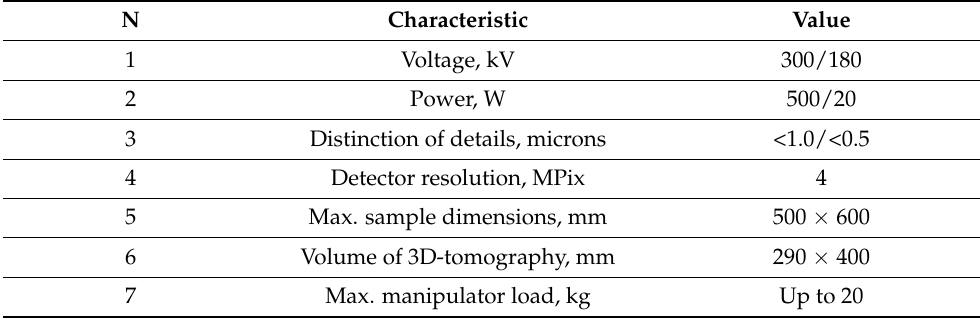
Table 1. GE v |tome| x m300 parameters.